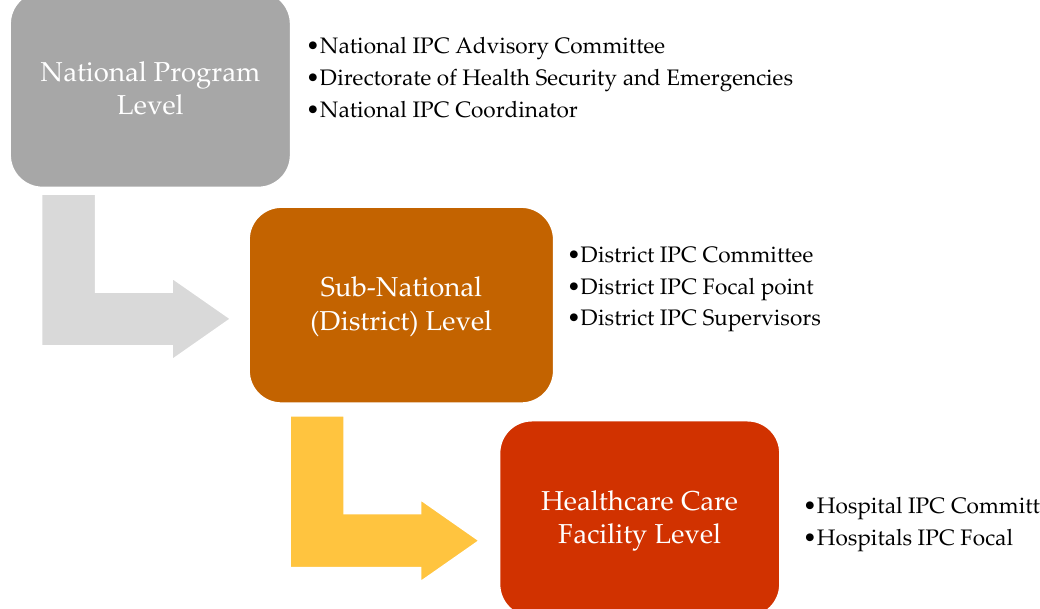
Figure 1. Organizational structure of IPC program in Sierra